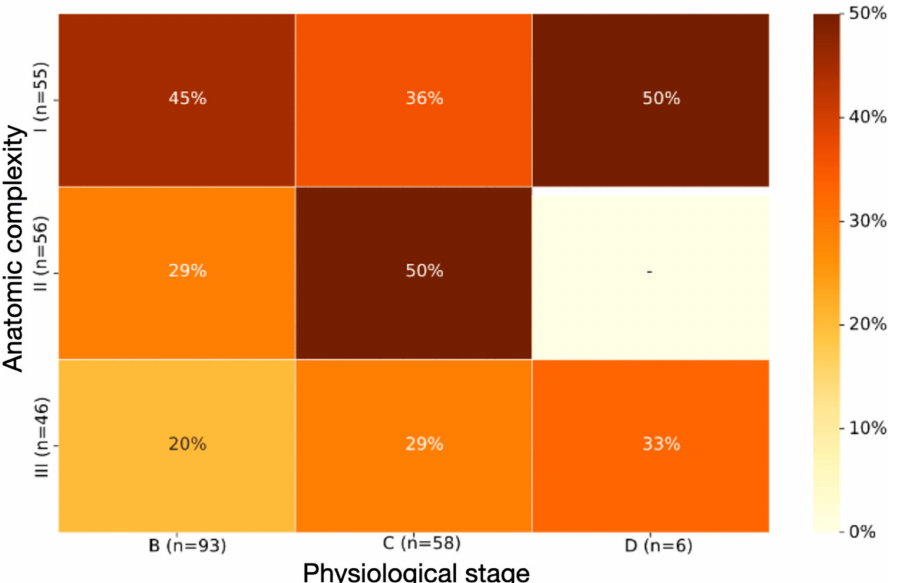
Figure 1. Probability of the composite outcome for various AP-ACHD classes based on Kaplan–Meier estimates. Kaplan–Meier estimates derived from maximum likelihood estimation of hazard function for each separate AP-ACHD class. For instance, the probability of the composite outcome occurring to patients in the IIIB AP-ACHD class is 20% at 20 months of follow-up (median follow-up duration). The cohort did not include any patient classified as IID. Hence, the probability of the outcome cannot be estimated for this subgroup. AP-ACHD, anatomic and physiological classification of adult congenital heart disease.